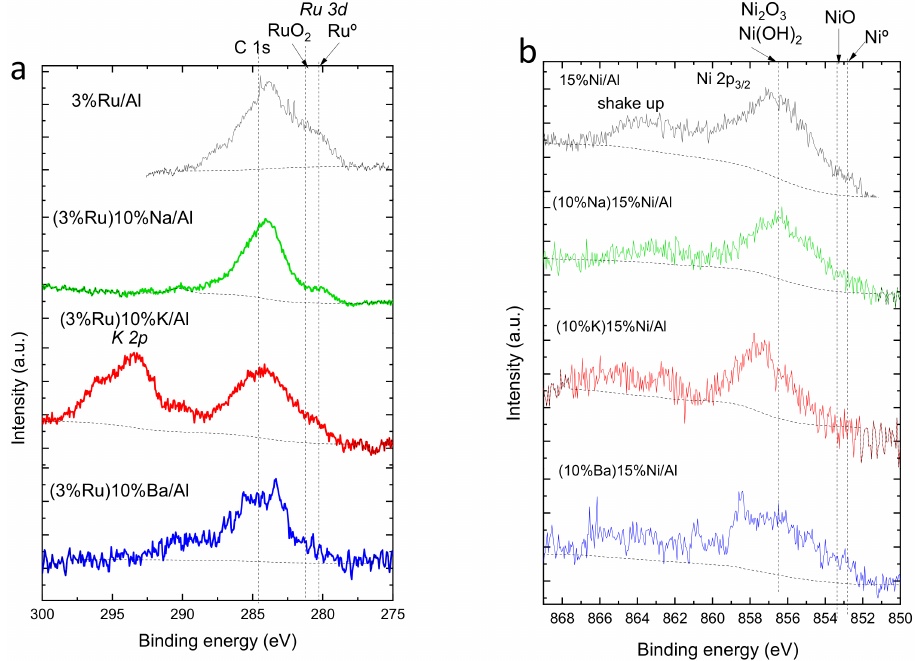
Figure 9. X-ray photoelectron spectroscopy characterization of the as-prepared materials before